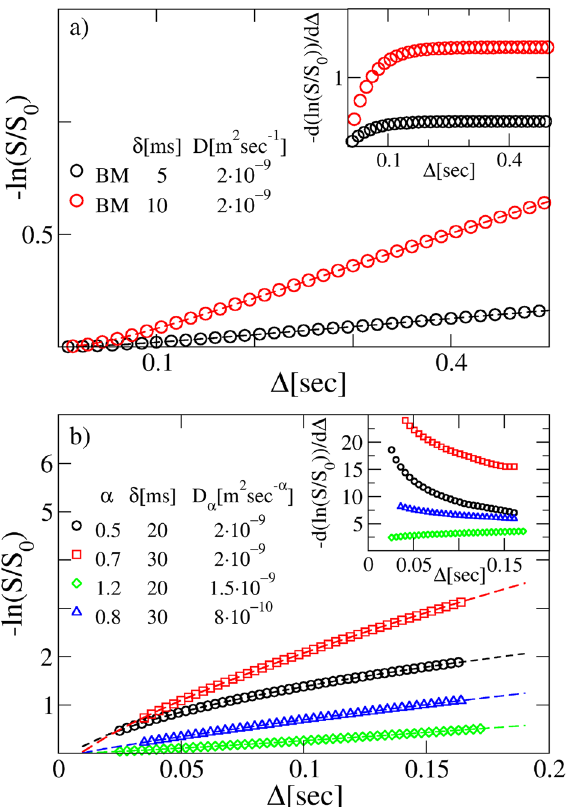
Figure 2. Panel ( a ) Normal diffusion. Main panel: comparison between synthetic DW-NMR signals obtained from normal diffusing trajectories and fitting curves obtained from Eq. (22) (dashed curves). The parameters 1 and g 0.01 T / m . The estimated D and ζ are reported in Table 1. The fitted parameters 20 s of BM are ζ − = = are in excellent agreement with the expected values (see SOM). Inset: the constant trend of the derivative of the normalized DW-NMR signals is shown. Panel ( b ) Anomalous diffusion echo amplitudes. Main panel: comparison between different synthetic DW-NMR signals obtained from FBM subdiffusive and superdiffusive trajectories (symbols), and relative fitting curves obtained through Eq. (24) (dashed curves). The signals 0.01 T/m. Inset : trend of the derivative of the logarithm of are obtained with a magnetic field gradient g = the normalized DW-NMR signals shown in the main plot. Superdiffusive (increasing trend as a function of the diffusion time) and subdiffusive (decreasing trend as a function of the diffusion time) systems are easily